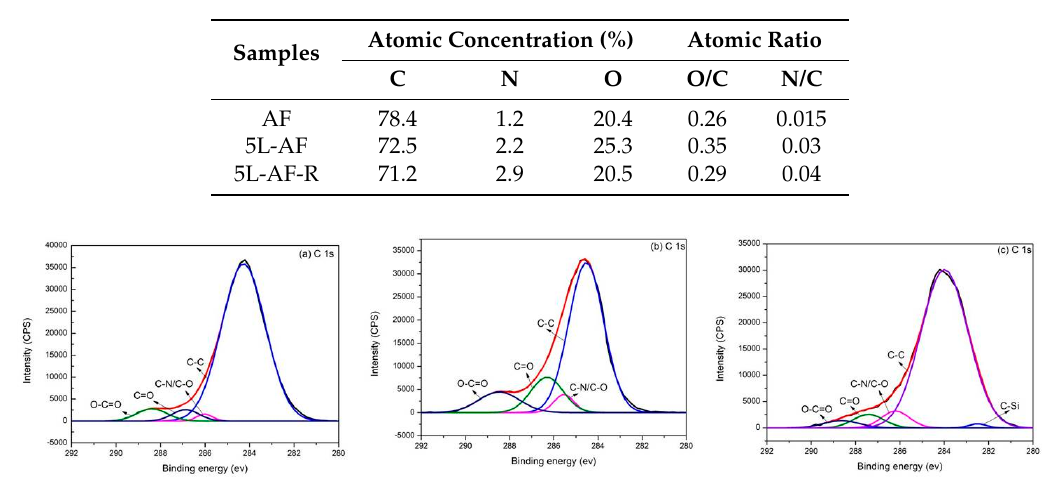
Figure 6. C1s spectra of aramid fibers before and after treatment with layer-by-layer self-assembly of L -PDOPA and electrostatic adsorption acidification of silane coupling agents (KH550): ( a ) AF; ( b ) 5L-AF; ( c ) 5L-AF-R. Table 4 . Deconvolution analyses of C1s peaks of aramid fibers before and after treatment with layer-by-layer self-assembly of L -PDOPA and electrostatic adsorption acidification of silane coupling agents (KH550).